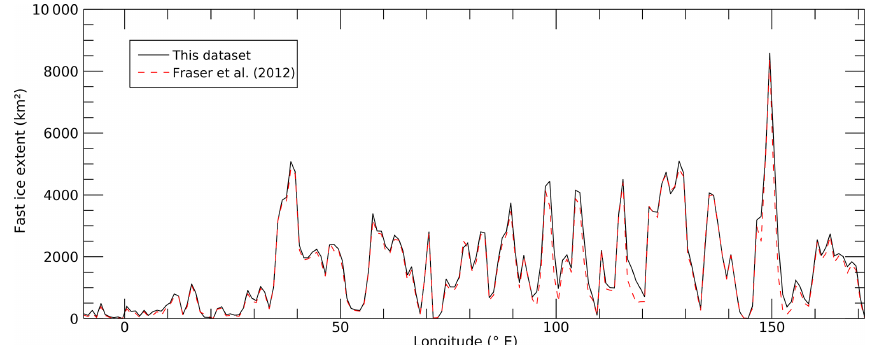
Figure 4. Mean fast-ice extent per degree of longitude for this new improved dataset (black solid line) and Fraser et al. (2012) (dashed red line), for the period and region of time series overlap (March 2000 to December 2008, 10 ◦ W to 172 ◦